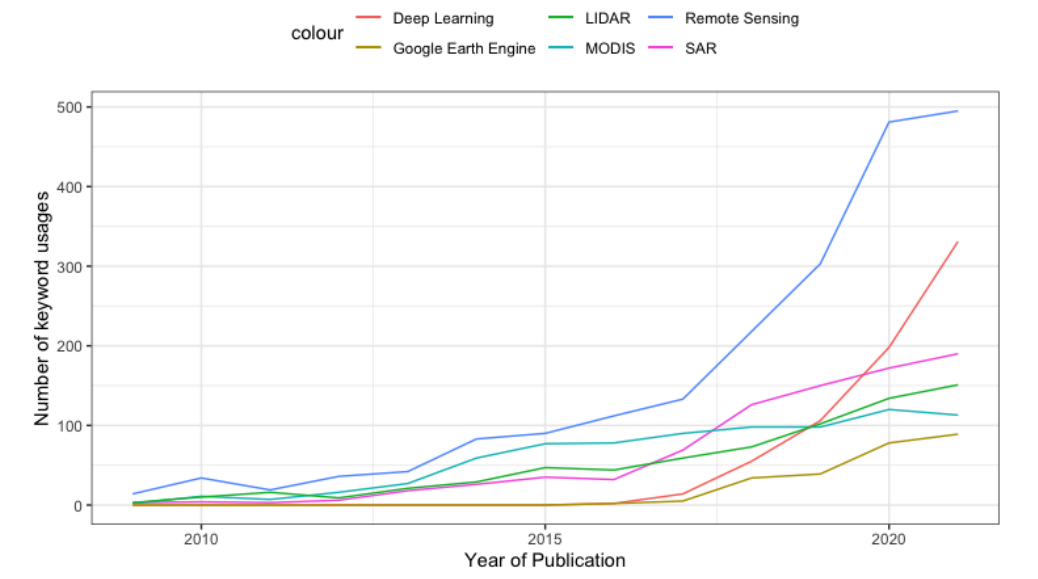
Figure 4. Number of selected keywords used in articles published in Remote Sensing between 2009 and 2021.